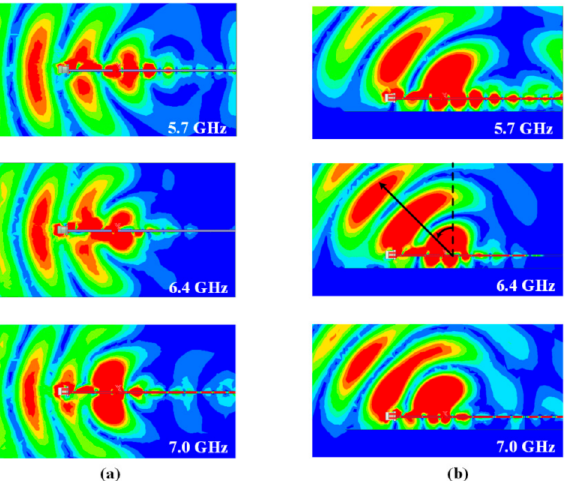
Figure 11. Electric field distribution of the proposed antenna in YOZ plane. ( a ) without the metal plate, ( b ) with the metal plate ( h g = 8